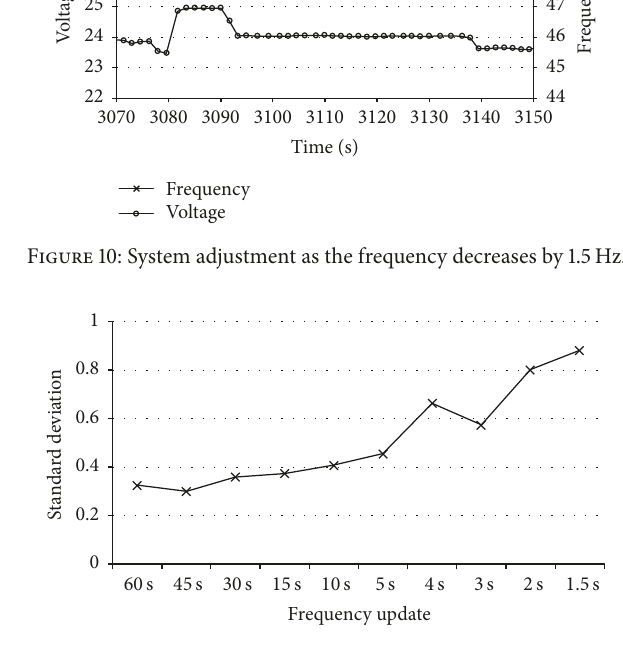
Figure 11: Standard deviation at various controller update